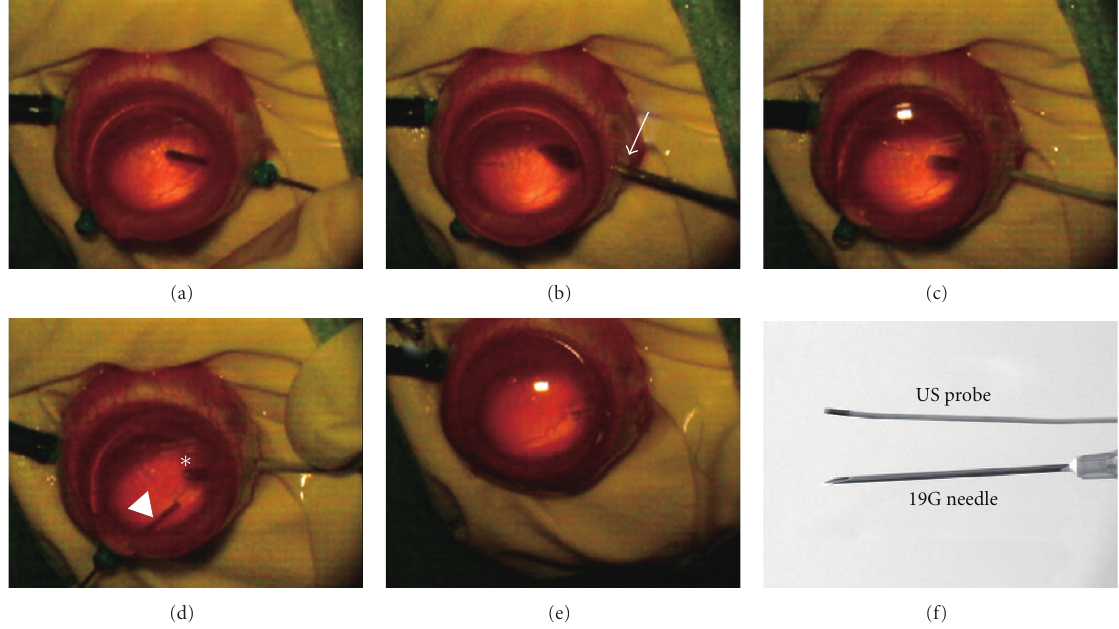
Figure 1: (a) Vitrectomy was performed with a 25-gauge vitrectomy system with rabbit eye. (b) Enlarge the superonasal incision with 19G needle (arrow) for the insertion of the US probe. (c) The eye ball had preserved intact after insertion of the US probe. (d) Bubble liposome was injected through the superotemporal port (arrowhead) and US irradiation (asterisk) was performed simultaneously. (e) The eye ball was kept intact after whole procedures. (f) The US probe size is as small as a 19G needle.